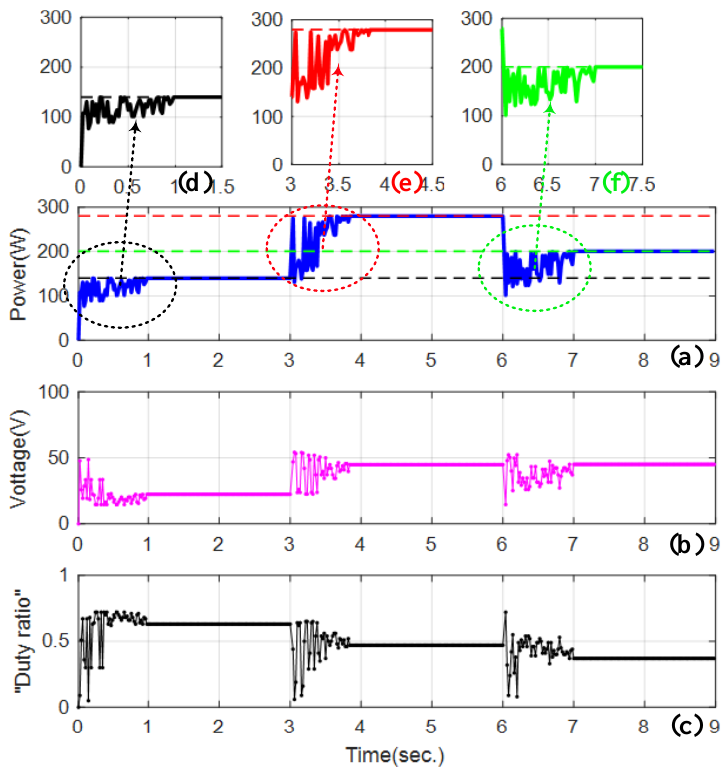
Figure 11. Results of the PSO method for two serial panels. ( a ) PV power, ( b ) PV voltage, ( c ) duty ratio, and ( d – f ) transient trajectories for situations 1 – 3, respectively. (Black --, red --, green --: global maximum values of situations 1 – 3).